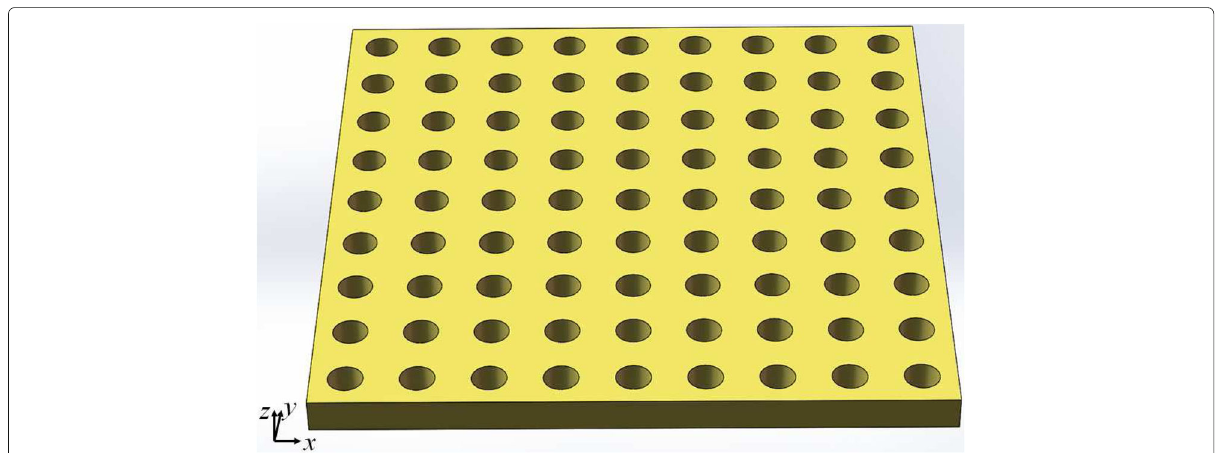
Fig. 1 Schematic diagram of the periodic plasmonic nanostructure